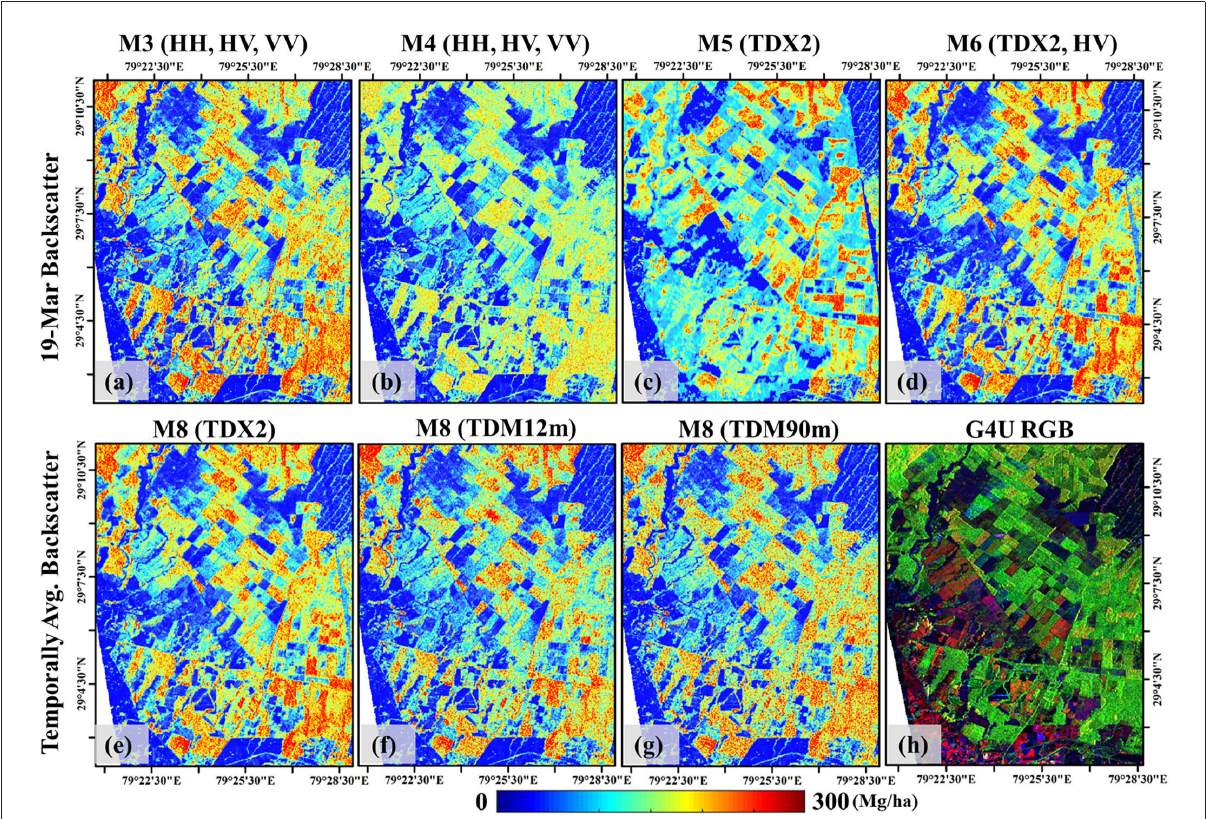
FIGURE10 AGB maps generated for different models. (A,B) are AGB maps generated using M 3 and M 4 models for L-band data acquisition on 19-March. (C) utilizes the M 5 model with the TDX2 height as input, whereas (D) shows the AGB map using the M 6 model for 19-March data and TDX2 height. (E–G) represents maps for M 8 model which utilize the temporally averaged backscatter as input with TDX2, TDM12m and TDM90m heights respectively. The G4U RGB image is shown in (H) for visual reference. Here the dihedral scattering, volume scattering and surface scattering are represented by red, green and blue colors